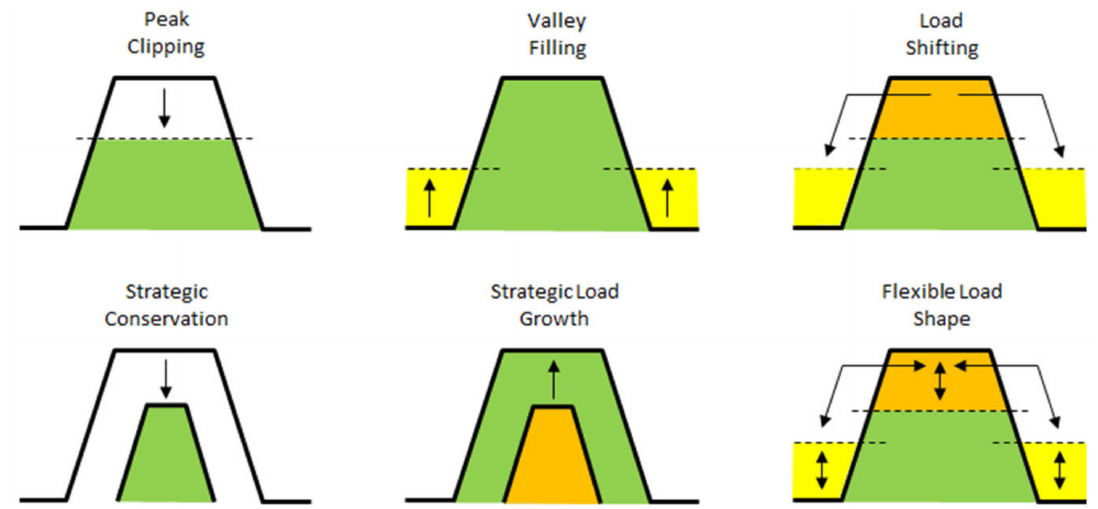
Figure 5. Objectives of demand-response